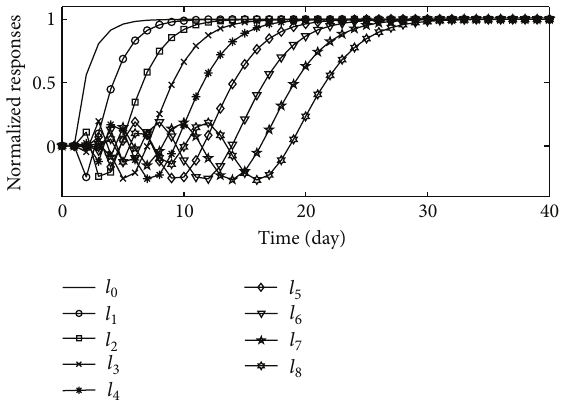
Figure 3: The step responses of Laguerre bases filters.